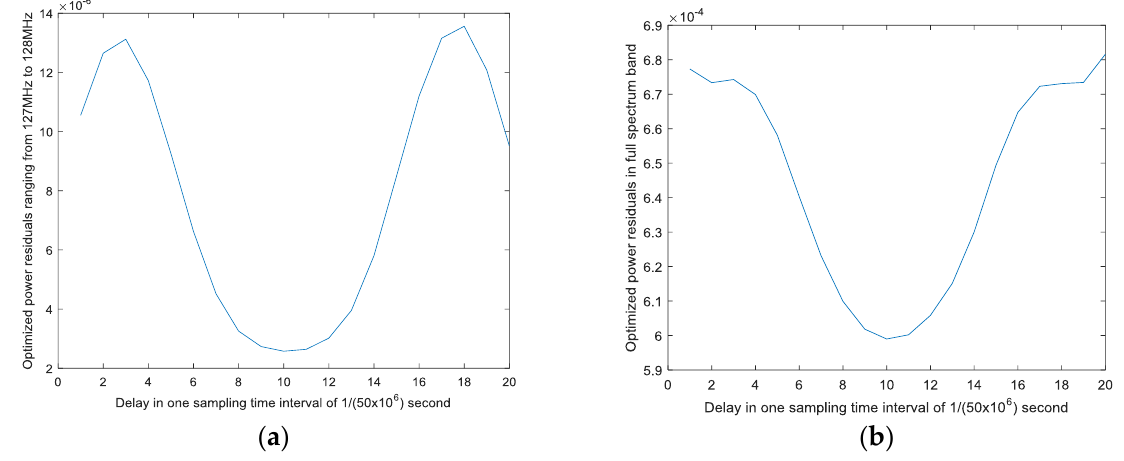
Figure 6. Relationships between delay and power residuals after optimization: ( a ) optimized power residuals in false-alarm region; and ( b ) optimized power residuals in full spectrum band.